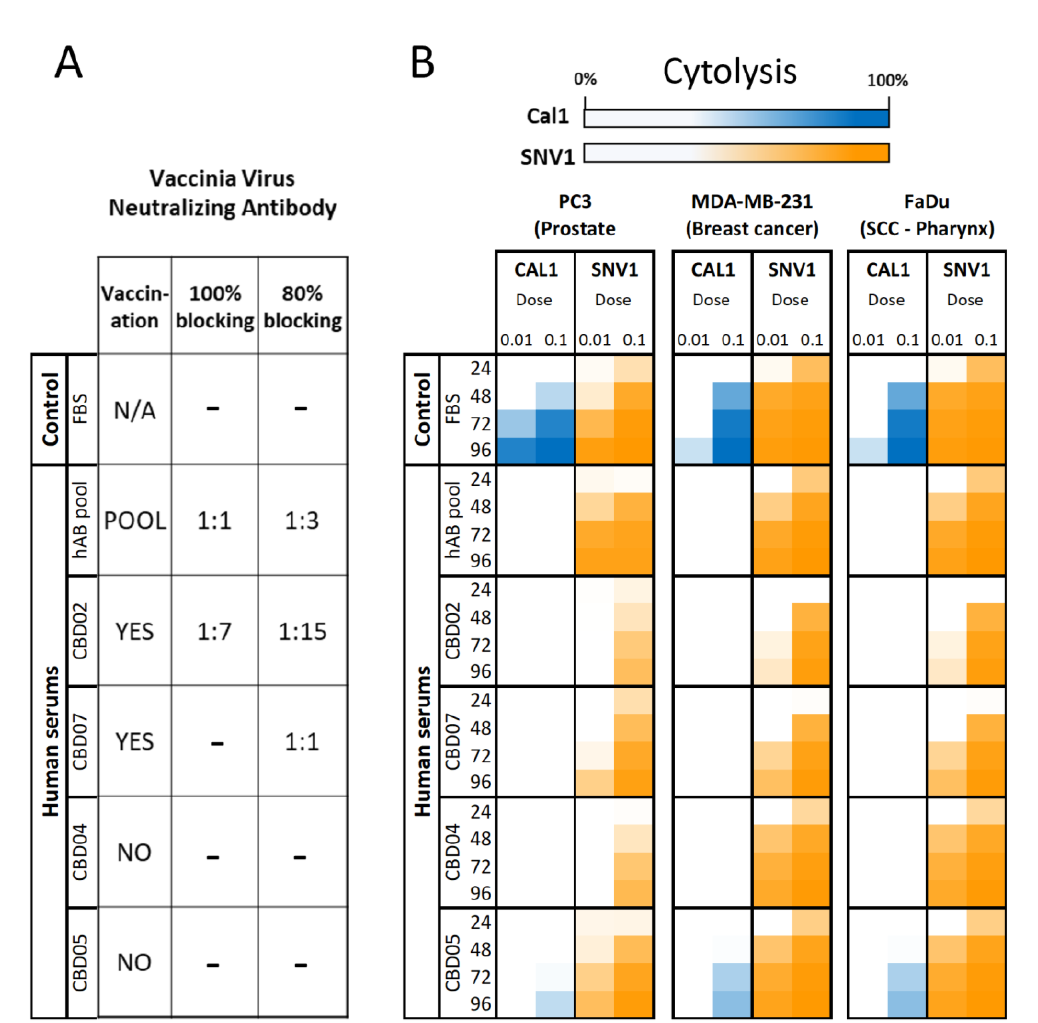
10 4 cancer cells per well, SNV1 treatment at MOI 0.1 (MOI based on infection units)